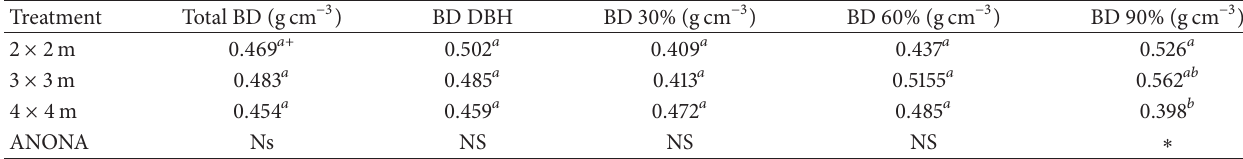
Table 3: Effect of spacing on wood density of T. grandis at LFP.